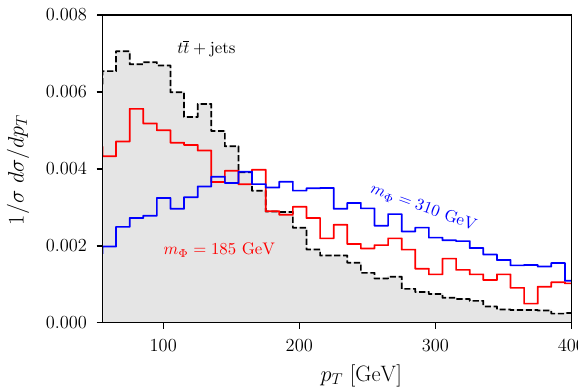
cross section is independent of scalar to fermion couplings,